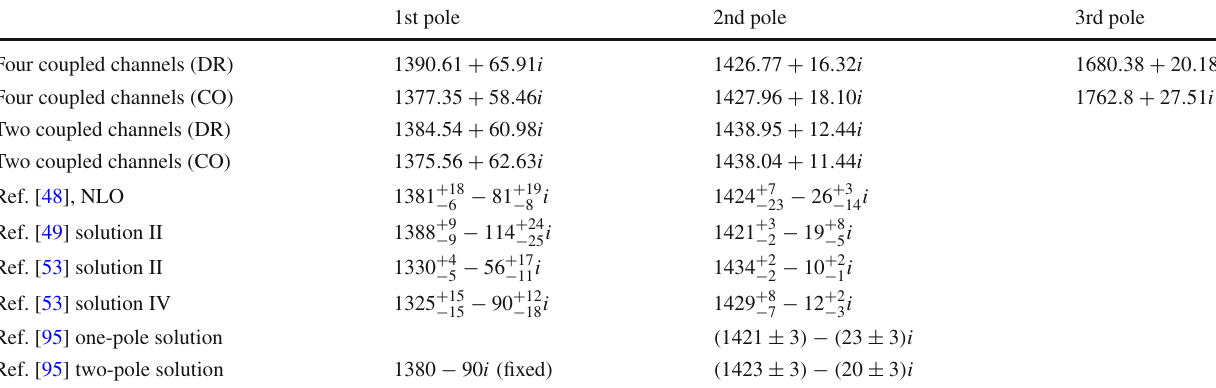
Table 1 Poles positions ∗ compared with the other works and experimental results (Unit: